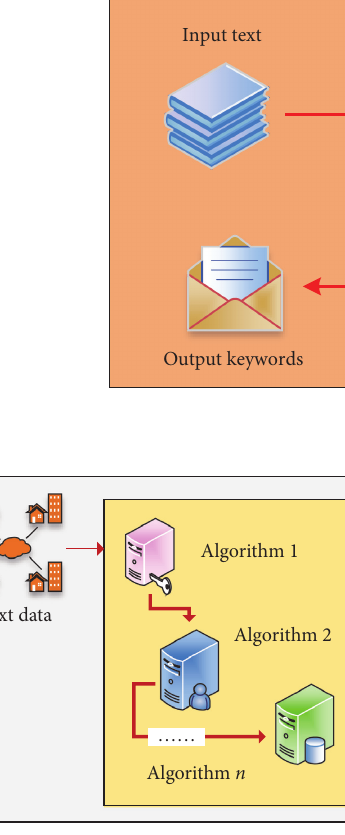
Figure 4: Waterfall fusion flow chart.